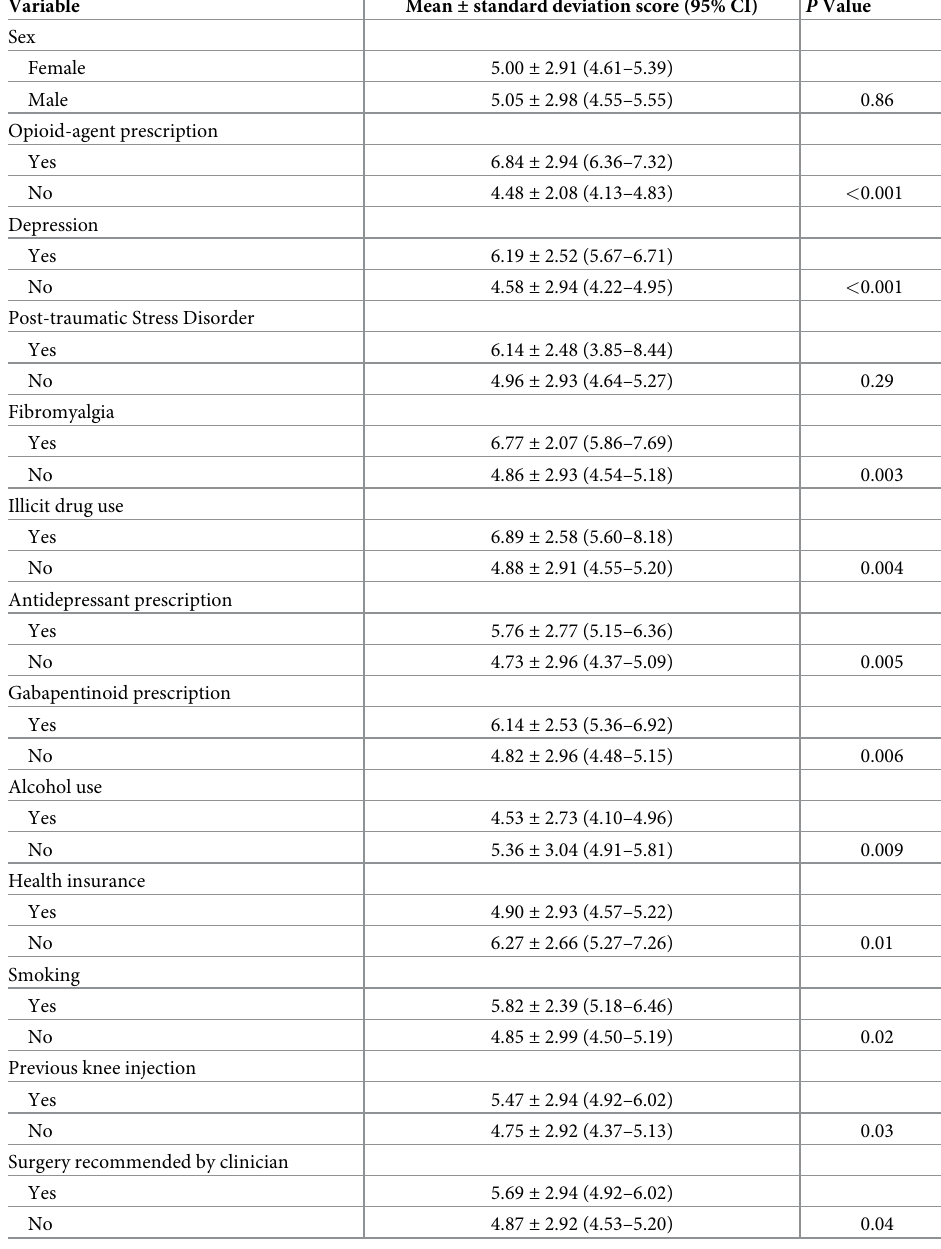
Table 2. Association of binary variables and pain score on univariate